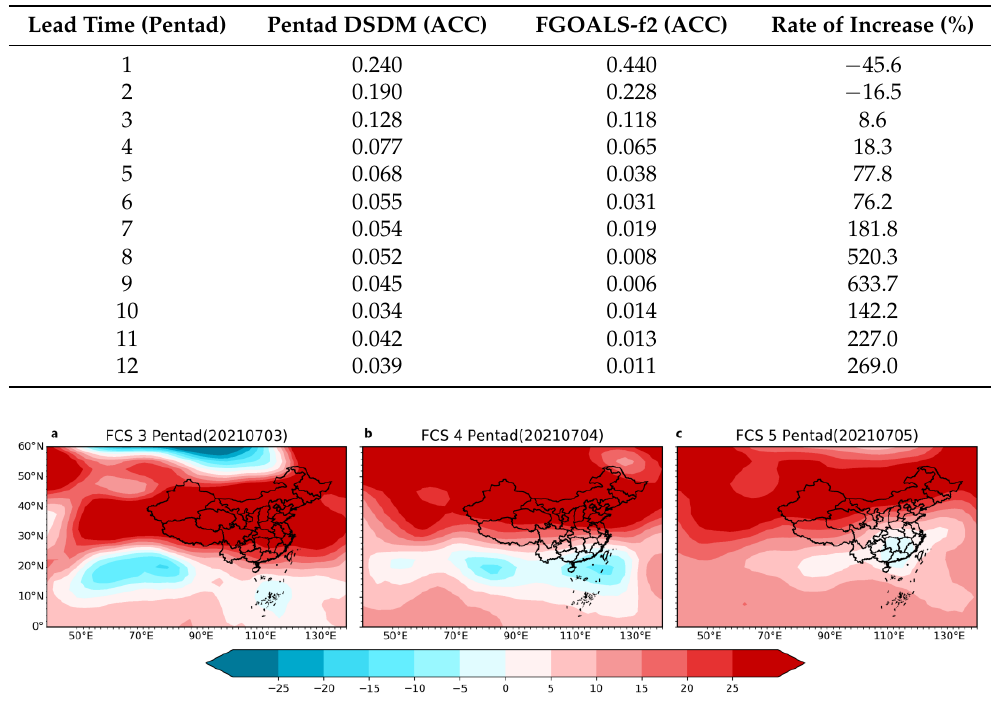
Table A1. ACC scores for each leading pentad over China (the rate of increase was calculated using Equation (A1)).